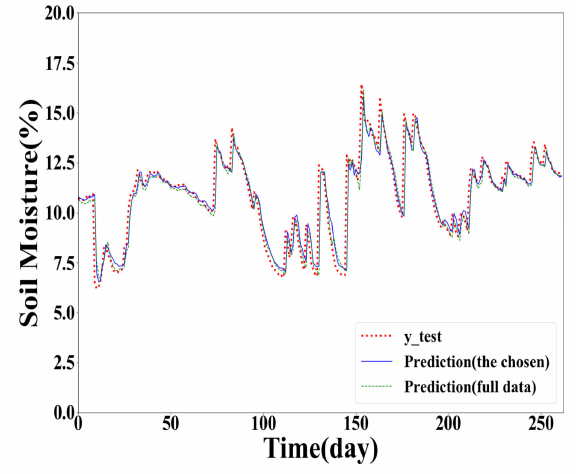
Figure 2. Points forecasting results in Y(1) prediction.